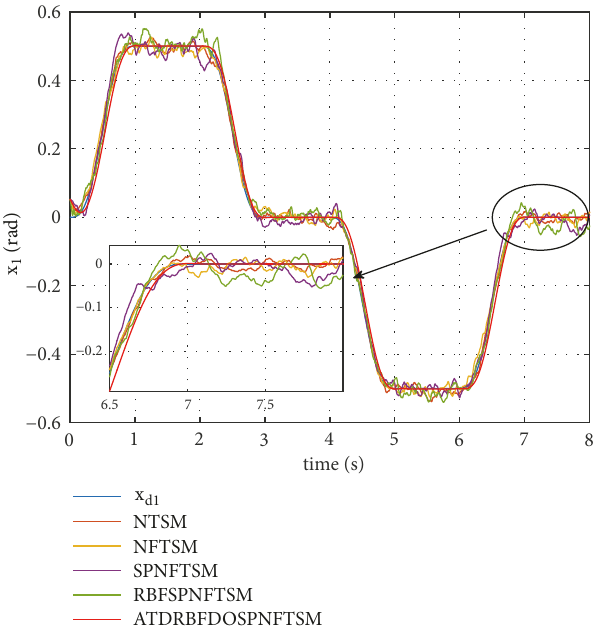
Figure 11: Swing angle tracking curve (adding noise).